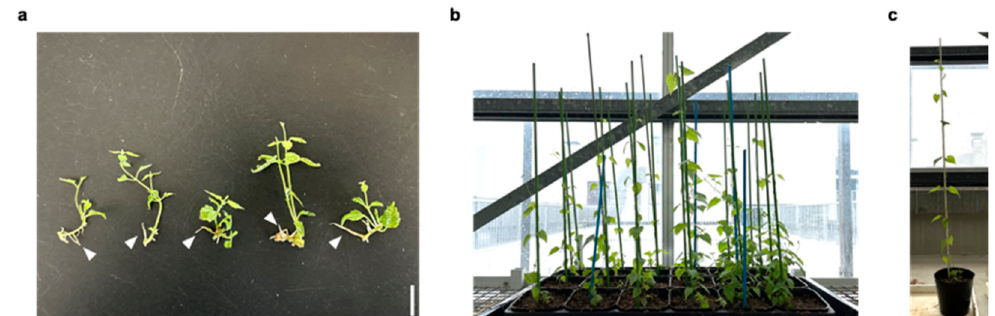
Figure 6. Rooting and transplanting of hop. ( a ) Stem explants with roots of the hop cultivar Kirin-2 at 2 weeks after the induction of rooting with 0.05 ppm 1-Naphthaleneacetic acid. The white arrowheads indicate the roots. Scale bar: 1 cm. ( b ) Plantlets of the hop cultivar Kirin-2 at 1.5 months after transplanting. ( c ) Plantlets of the hop cultivar Kirin-2 at 2 months after transplanting.